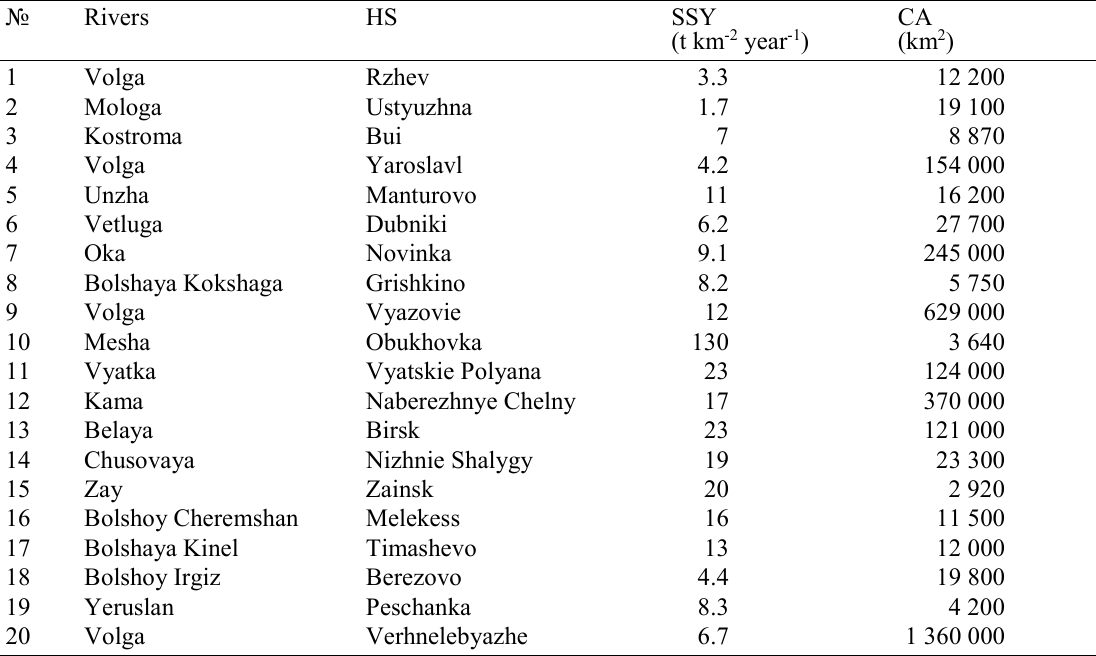
Table 1 Suspended sediment yield from the some major tributary river basins in the Volga River